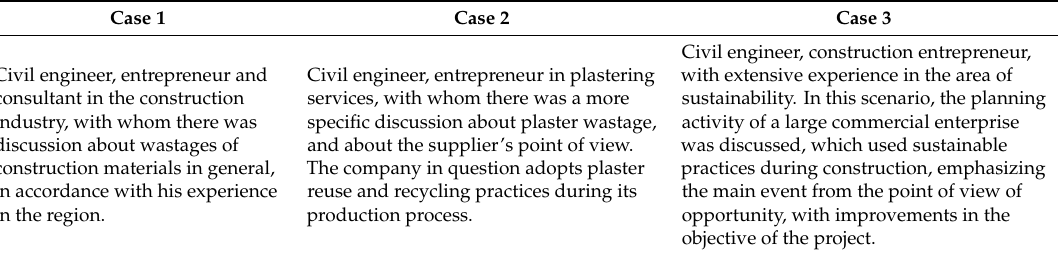
Table 1. Cases and specialists in this